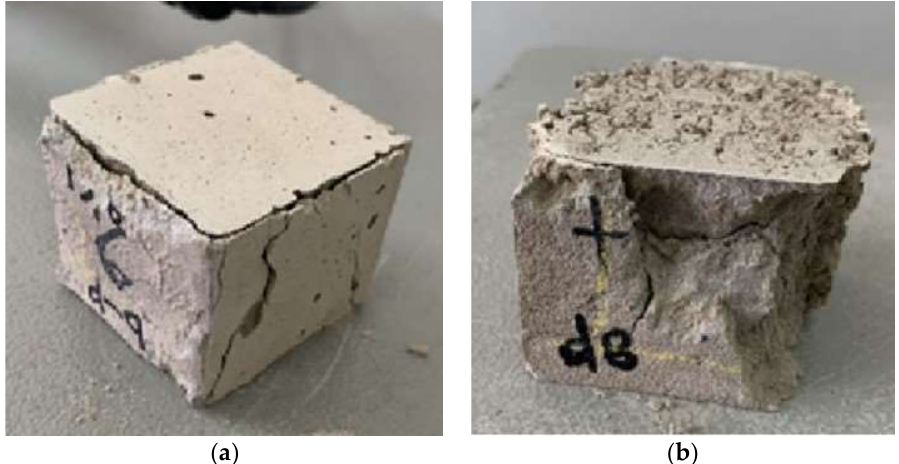
Figure 6. ( a ) Cracked pattern failure for mortar sample mix 30 under compressive strength test; ( b ) Cracked pattern failure for mortar sample mix 26 under compressive strength test.